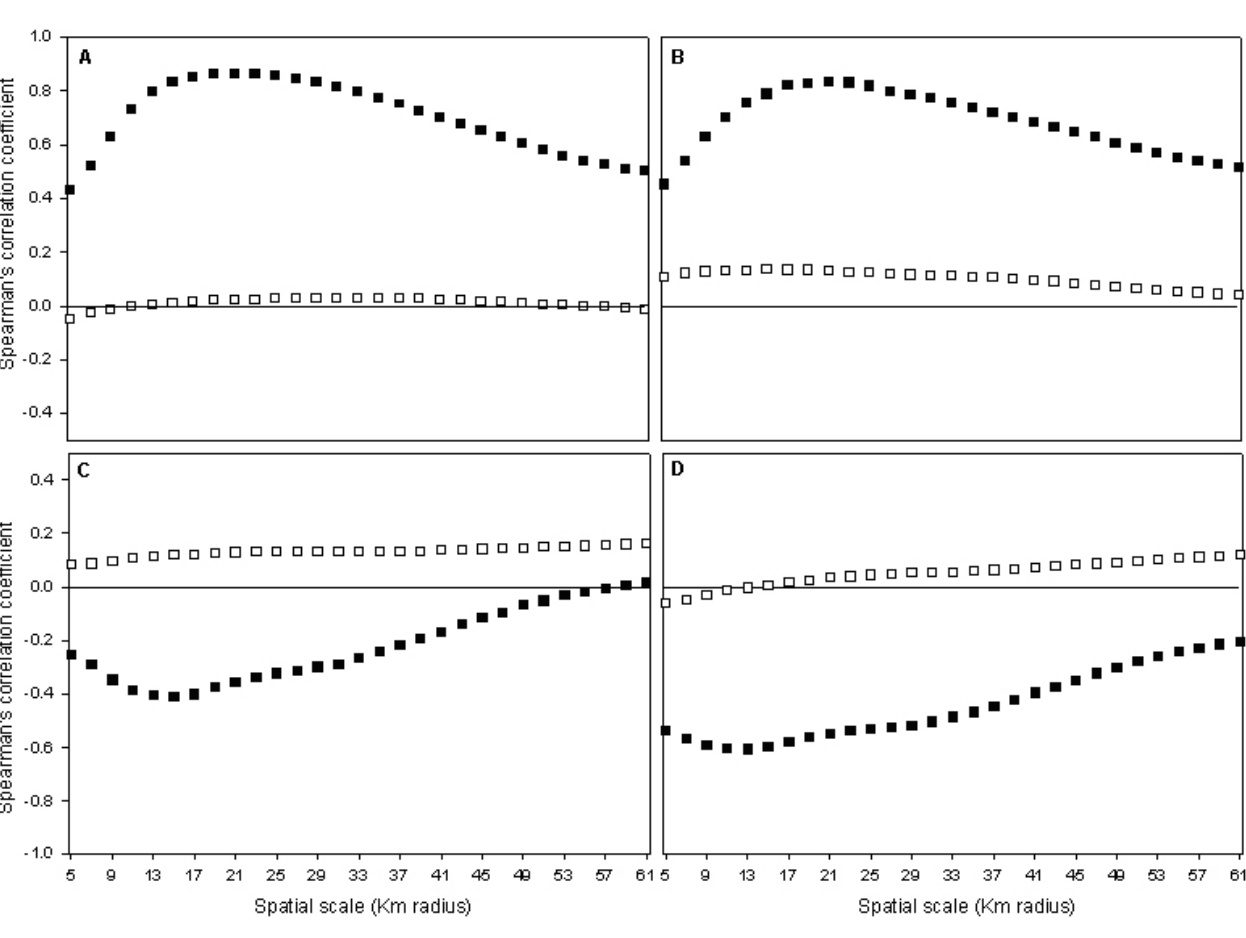
Fig. 4 . Wild boar reintroduction success in relation to habitat availability, i.e., number of habitat cells, and quality, i.e., breeding capacity of these cells, in a radial neighborhood of different scales. A and B represent population expansion or number of cells colonized in relation to habitat availability and quality, respectively; C and D represent extinction probability in relation to the same variables. Black squares: 50% forest coverage required; white squares: 10% forest coverage required. The number of habitat cells in a given subarea is related to the proportion of forest in a particular landscape, whereas breeding capacity is influenced by the composition of the